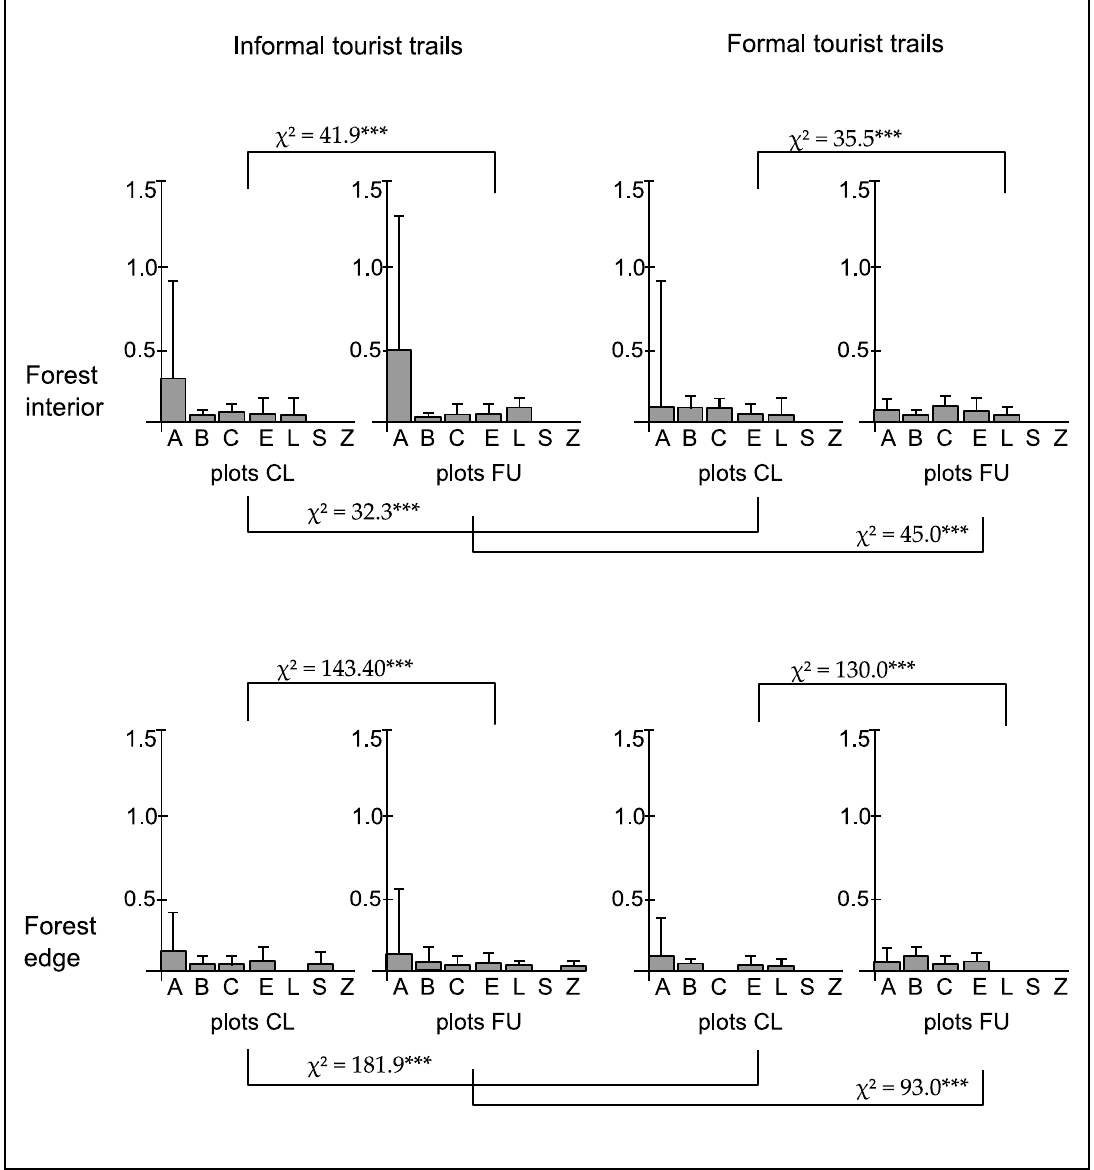
Figure 10. The mean cover-abundance degree of species (±SD) representing Allium (A), Bidens (B), Cornus (C), Epilobium (E), Lycopodium (L), Sparganium (S) and Zea (Z) dispersal type per plot in closer (CL) and further (FU) plots located along informal (width < 50 cm) and formal (width > 150 cm) tourist trails within the forest interior and forest edge sites. The statistical significance level is explained in Figure 2.